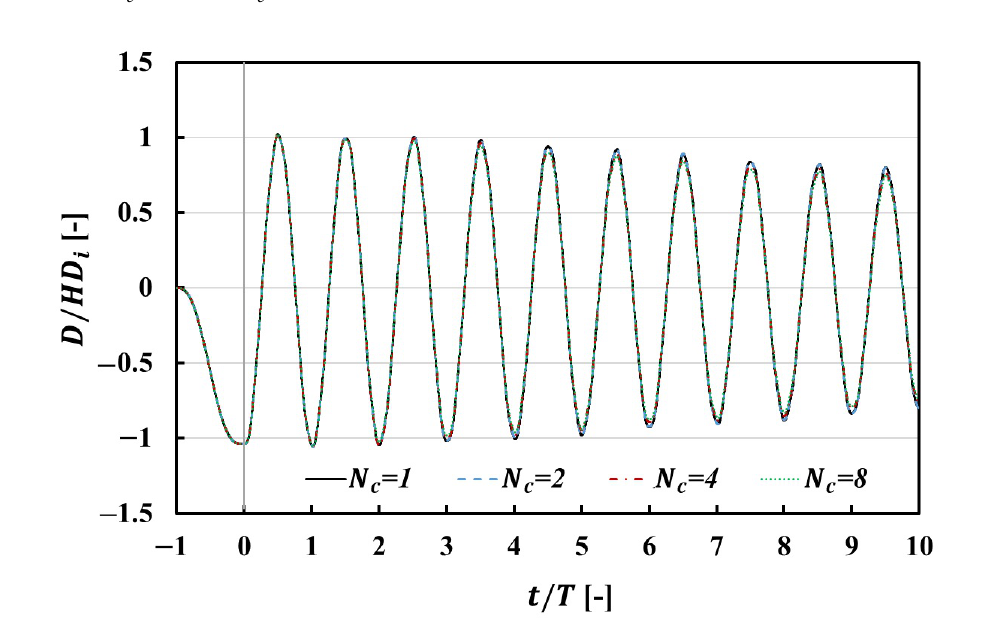
Figure 18. Time history of non-dimensional tip vertical displacement of the system normalised by the initial excitation amplitude over ten cycles for D i =